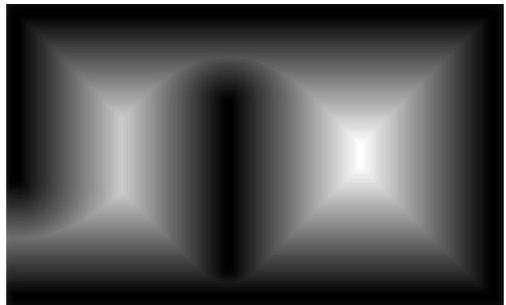
Figure 4. The result of the DT method using Euclidean distance.